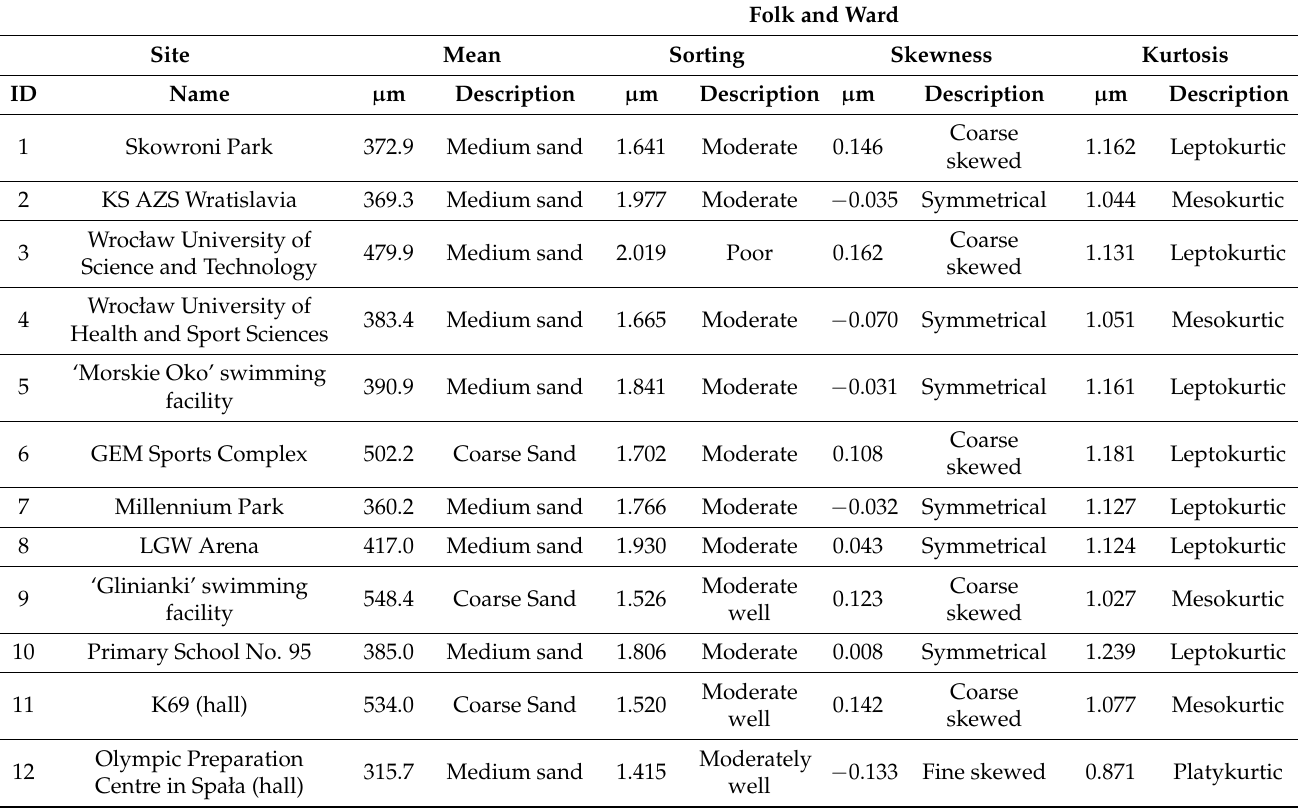
grains. The distinctive sample is the one from the CSC-OPC court, which is skewed